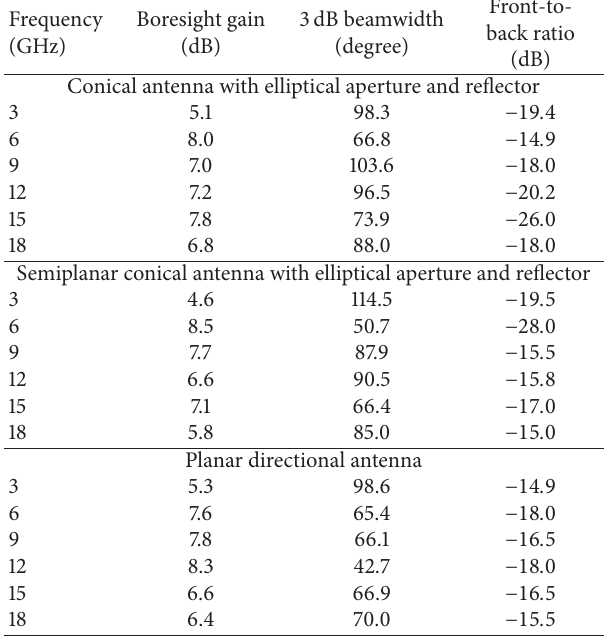
Table 1: Comparison of some parameters of directional